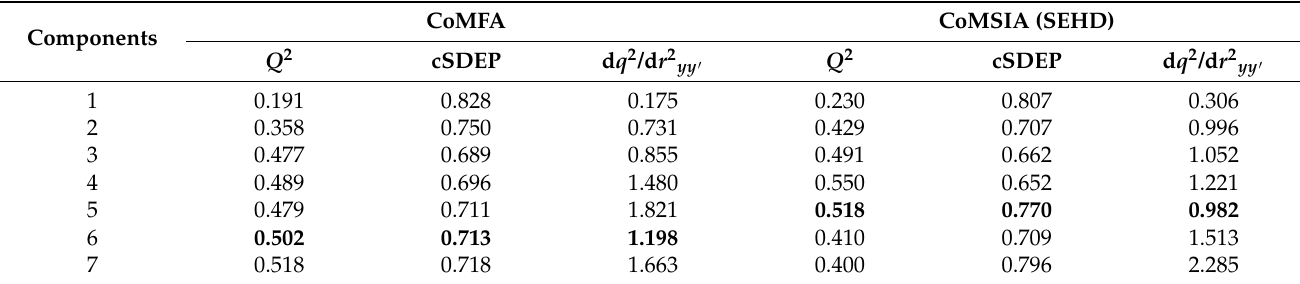
Table 4. Progressive scrambling results from the CoMFA and CoMSIA(SEHD) training set compounds.